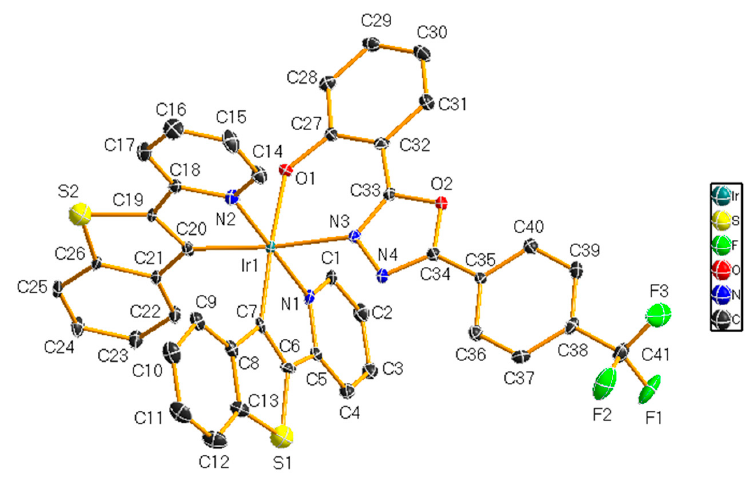
Figure 5. X-ray single crystal diffraction pattern of coordination compound Ir2 crystal structure.